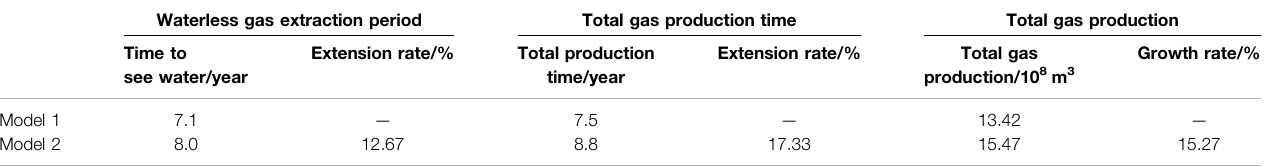
TABLE 5 | Quantitative comparison statistics of simulation results from different models. Waterless gas extraction